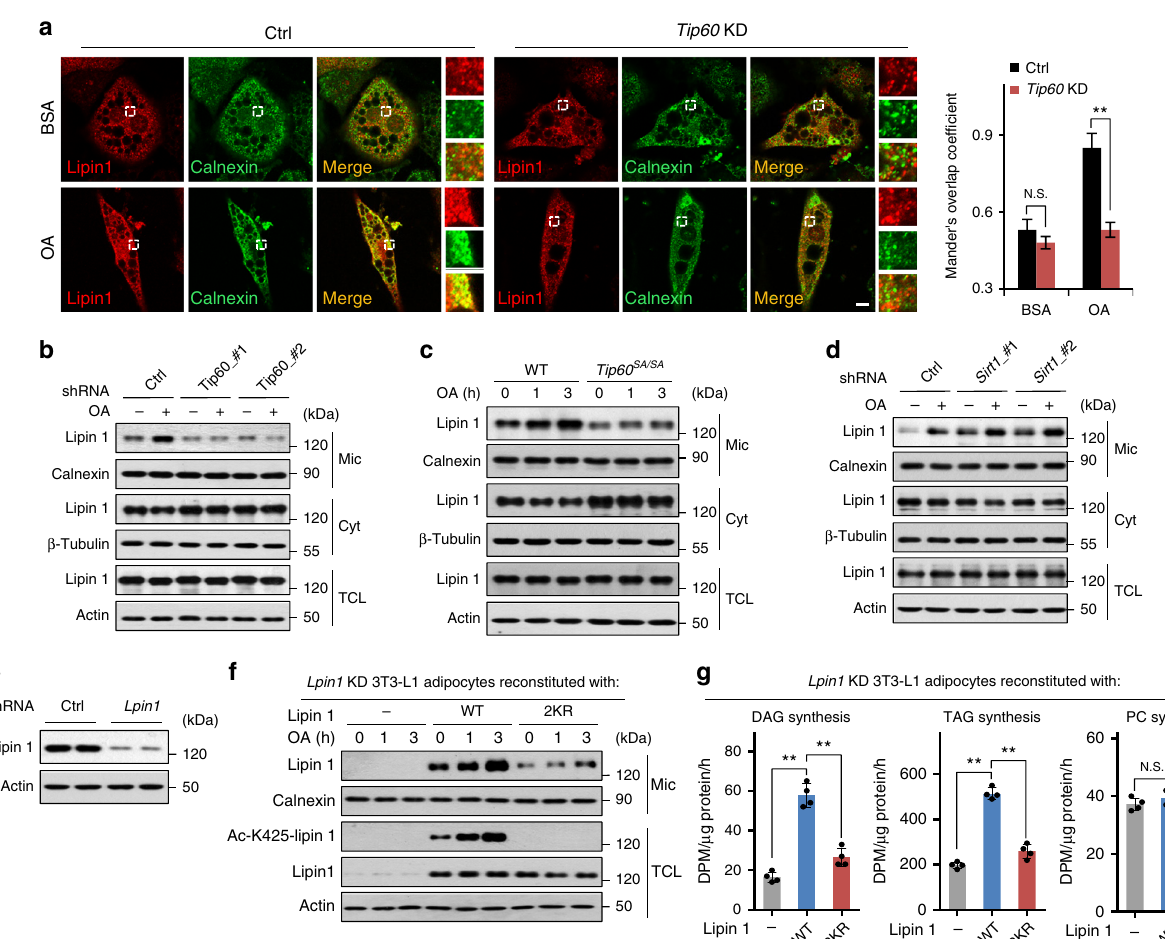
Fig. 5 Tip60-mediated lipin 1 acetylation leads to lipin 1 translocation from cytosol to ER membranes. a Attenuated translocation of lipin 1 from cytosol to ER membranes after Tip60 depletion. Representative images ( n = 3 replicate experiments) of 3T3-L1 adipocytes expressing control shRNA (ctrl) or shRNA targeting Tip60 ( Tip60 KD) treated with BSA or OA for 2 h. Calnexin is an ER/microsomal marker. Mander ’ s overlap coef fi cients between lipin 1 and Calnexin were graphed ( n = 30 for each group). Scale bar, 10 μ m. b Depletion of Tip60 impairs lipin 1 ER localization. Western blotting of proteins in subcellular fractions of 3T3-L1 adipocytes expressing control shRNA (ctrl) or shRNAs targeting Tip60 treated with or without OA for 3 h. Calnexin, microsomal (Mic) marker; β -tubulin, cytosol (Cyt) marker. c Impairment of lipin 1 ER localization in adipocytes derived from Tip60 SA/SA MEFs. Adipocytes (differentiation day 8) derived from WT or Tip60 SA/SA MEFs were treated with OA for 1 – 3 h and analyzed by fractionation, followed by western blotting. d Depletion of Sirt1 promotes lipin 1 ER localization. e Knockdown of Lpin1 in 3T3-L1 adipocytes. Western blotting of proteins of 3T3-L1 adipocytes expressing control shRNA (ctrl) or shRNA targeting Lpin1 . f , g Acetylation-dependent ER localization of lipin 1 and DAG/TAG synthesis. Western blotting of proteins ( f ) or DAG, TAG and PC synthesis rates ( g ) of 3T3-L1 adipocytes expressing shRNA targeting Lpin1 reconstituted with vector, WT-lipin 1 or 2KR-lipin 1 after OA treatment ( n = 4 experiments). Error bars denote SEM. Statistical analysis was performed by ANOVA followed by Tukey in a , g . ** P < 0.01; N.S. not signi fi cant. Uncropped blots can be found in Supplementary Fig. (Supplementary Fig. 4e). By contrast, lipin 1 dephosphorylation reduced its association with Sirt1 (Fig. 6c). Moreover, Tip60 and promotes its ER translocation 9 , we investigated possible interplay Sirt1 competed with one another for binding to lipin 1 (Fig. 6d). between dephosphorylation and acetylation of lipin 1 by exam- In line with these results, OA treatment promoted lipin 1 inter-